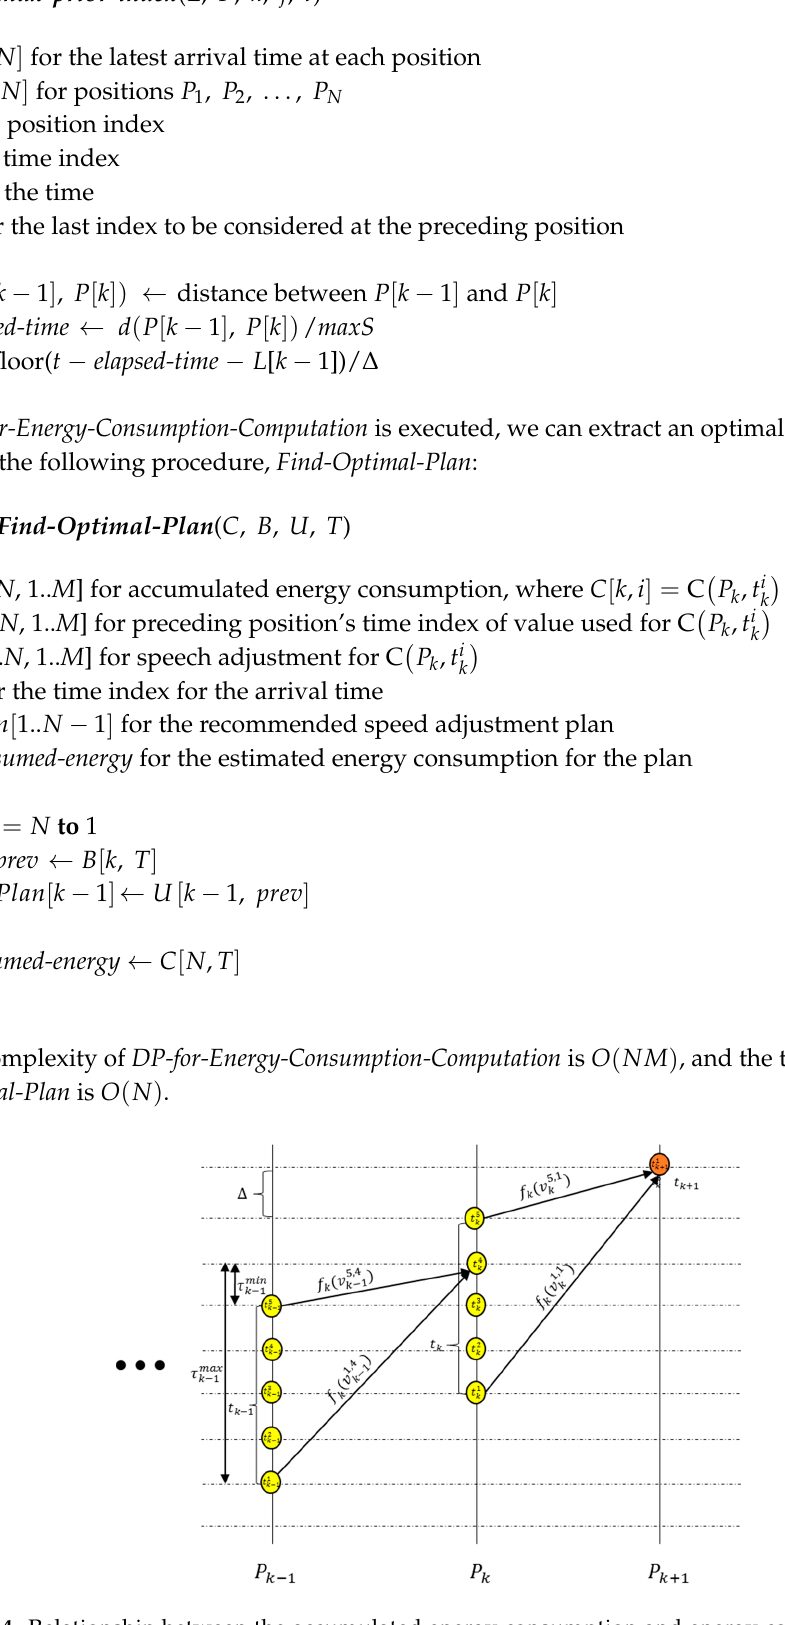
Figure 4. Relationship between the accumulated energy consumption and energy consumption by traveling to adjacent points.